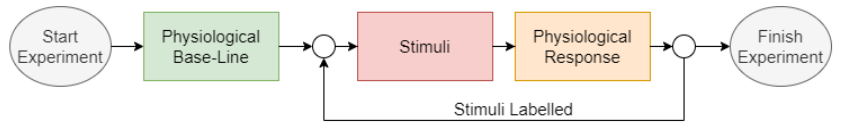
Figure 4. Flowchart of the experimental design during raw signal